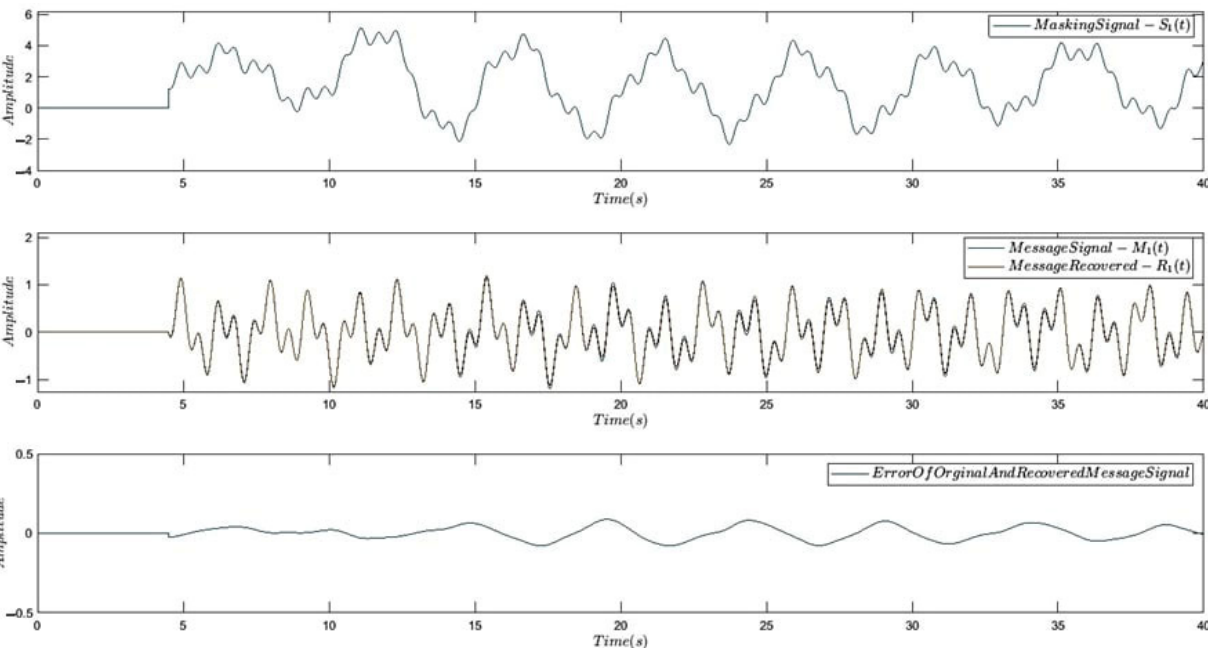
Figure 8. Chaotic secure communication structure based on the proposed approach.